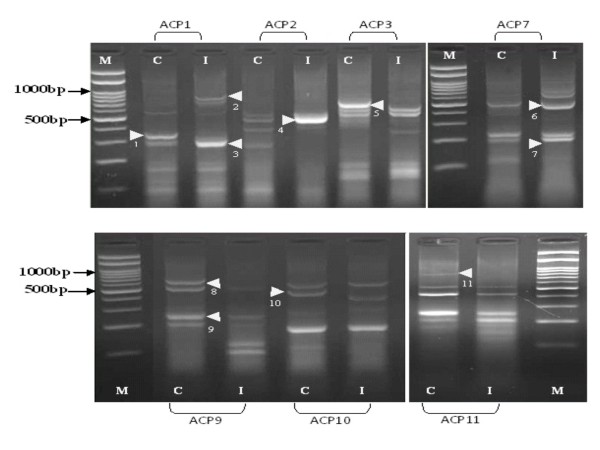
There are 11 bands, of which 5 of them are up regulated and 6 down regulated. The identities of these bands are presented in Table 3. M: 100 bp molecular marker; C: Control CeLu cell; I: CeLu cells infected with H5N1. Arrow indicates differential cDNA bands and each number indicates the DEG number.